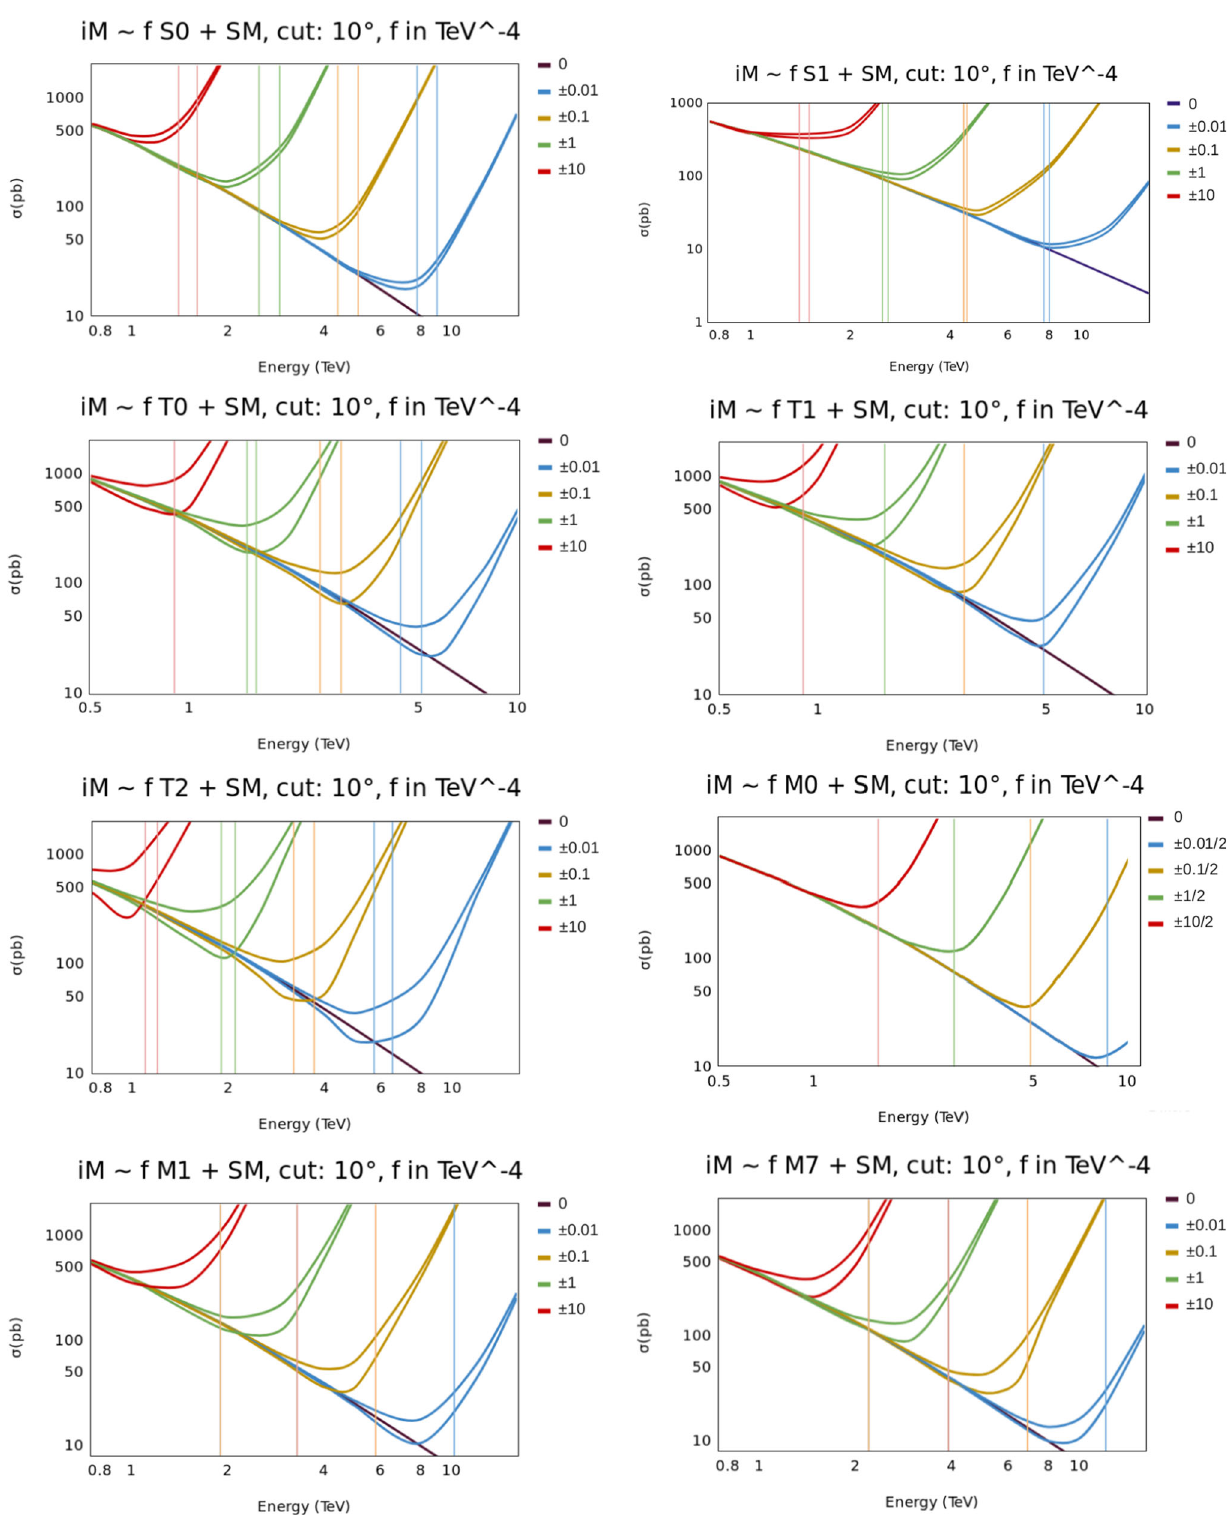
Fig. 8 Energy dependence of the total unpolarized W + W + cross sec- √ s , in TeV) for a chosen set of f i values. Vertical lines tions ( E CM ≡ √ s U (color correspondence). There is no denote the unitarity bound